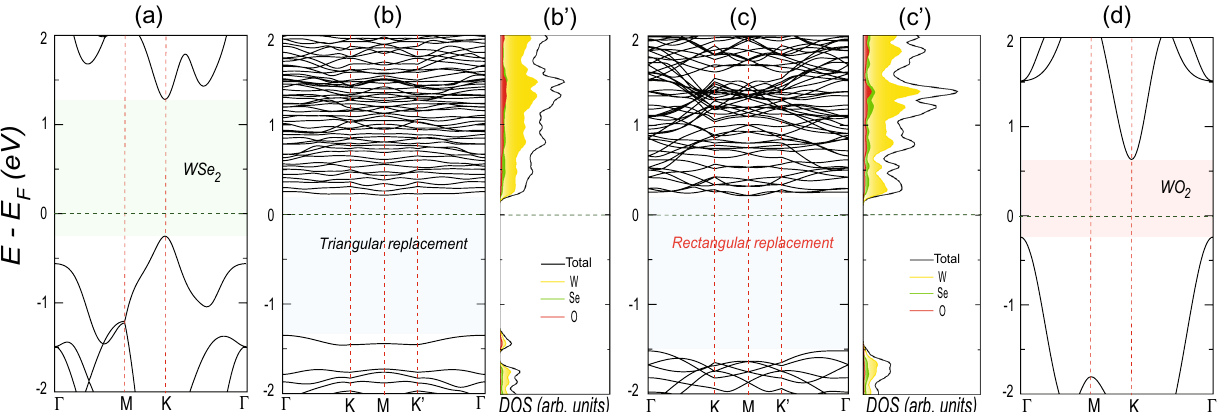
Figure 3. ( a ) Energy dispersion of pristine 2D monolayer of WSe 2 . The energy dispersions of in-plane selenide- oxide heterostructures with triangular (as in Fig. 1a) and rectangular (as in Fig.1b) oxide islands are shown in ( b ) and ( c ), along with their density of states in ( b ’) and ( c ’), respectively. The projected density of states from W, Se, and O atoms are also shown in different shades. The energy dispersion of monolayer WO 2 is shown in ( d ). In all the energy dispersion plots, the horizontal (vertical) dashed lines show the location of Fermi energy (high- symmetric points). Note that, in case of ( a ) pristine WSe 2 and ( d ) WO 2 , we consider single unit cell and regular hexagonal first Brillouin